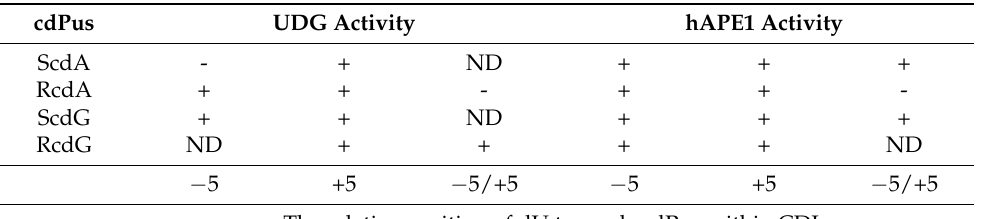
Table 4. The activity of UDG and hAPE1 towards dU within cdPus-containing CLD, in relation to controls: dU0 and dU( − 5)(+5)dA.